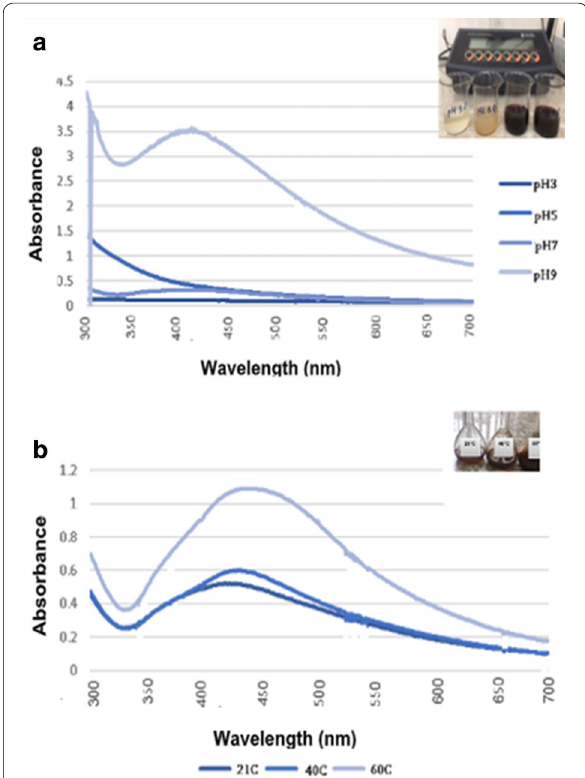
Fig. 3 UV-visible spectrum of green synthesized Ag NPs with different initial pH values ( a ) and at different temperature ( b ). For the others, see the legends to Fig. 2